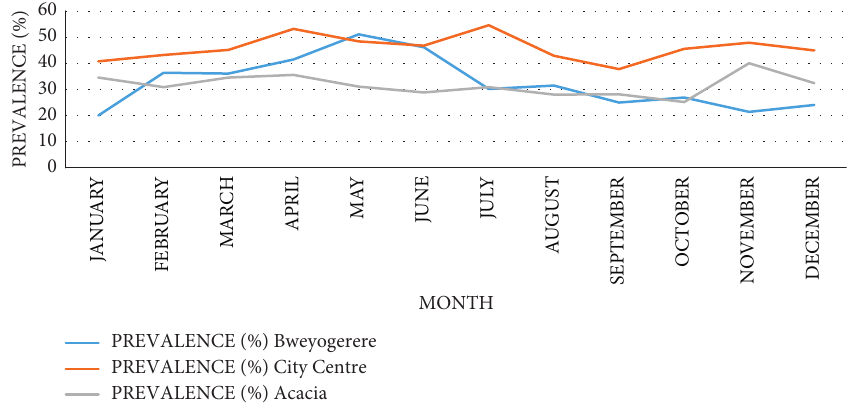
Figure 7: Clinic-specific temporal trend of H . pylori infection. Table 2: Multivariate logistic regression, epidemiological